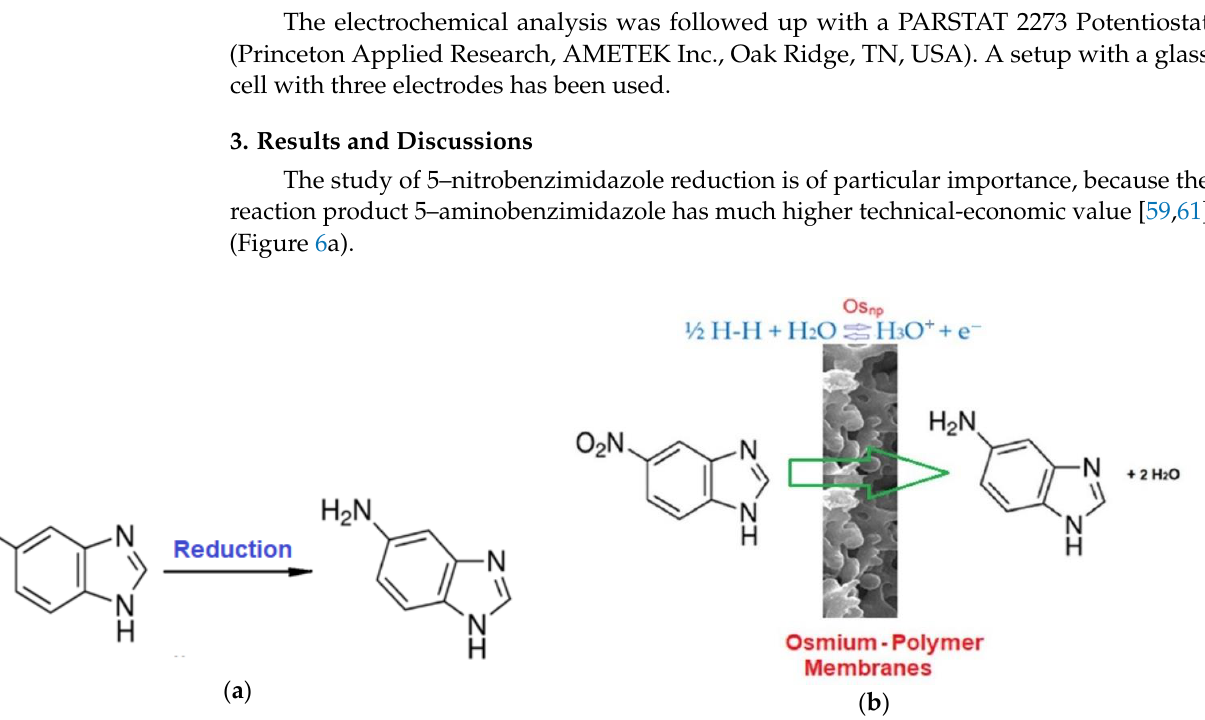
Table 1. The characteristics of the membrane supports. Membrane